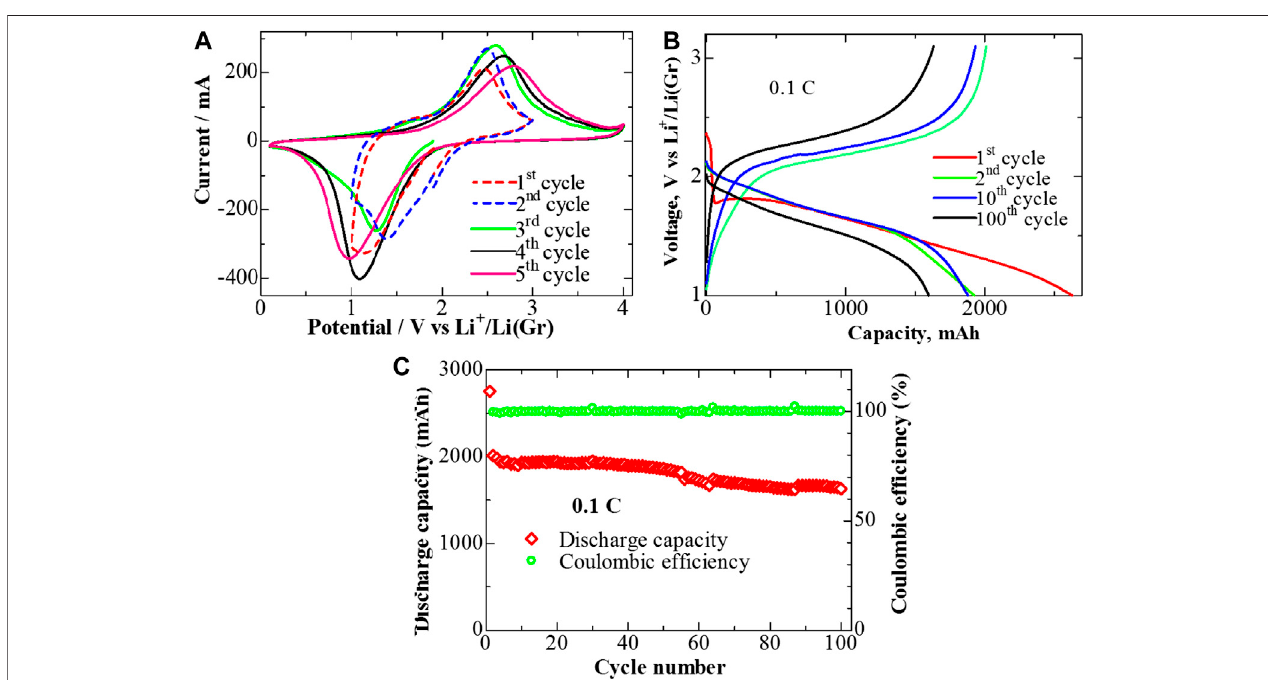
FIGURE 6 | CV curves at a scan rate 0.1 V s − 1 within potential windows (A) 1 – 3 V and (B) 0.1 – 4 V vs. Li/Li + ; (B) charge/discharge pro fi le; and (C) cyclability of the pouch cell within cutoff potentials 1 – 3 V vs. Li/Li +